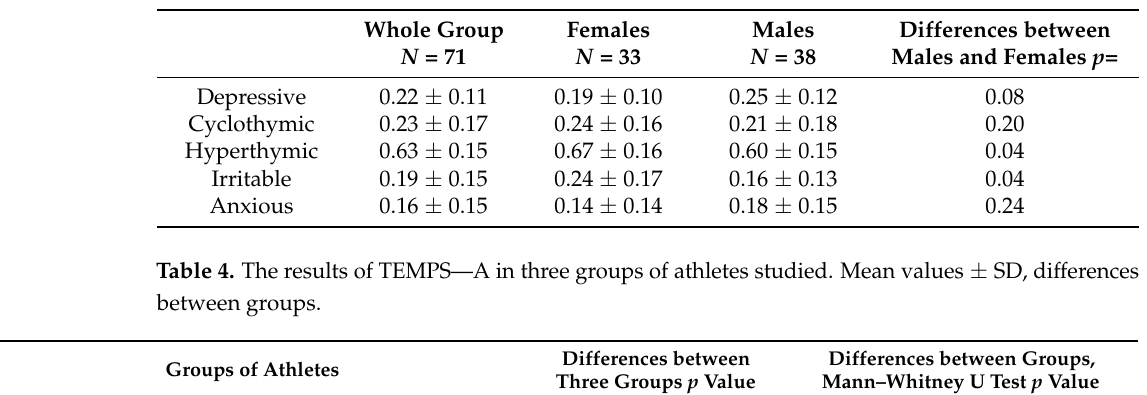
Table 3. The results of TEMPS—A in whole group.